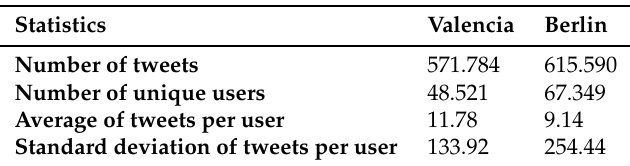
Table 1. General statistics of the